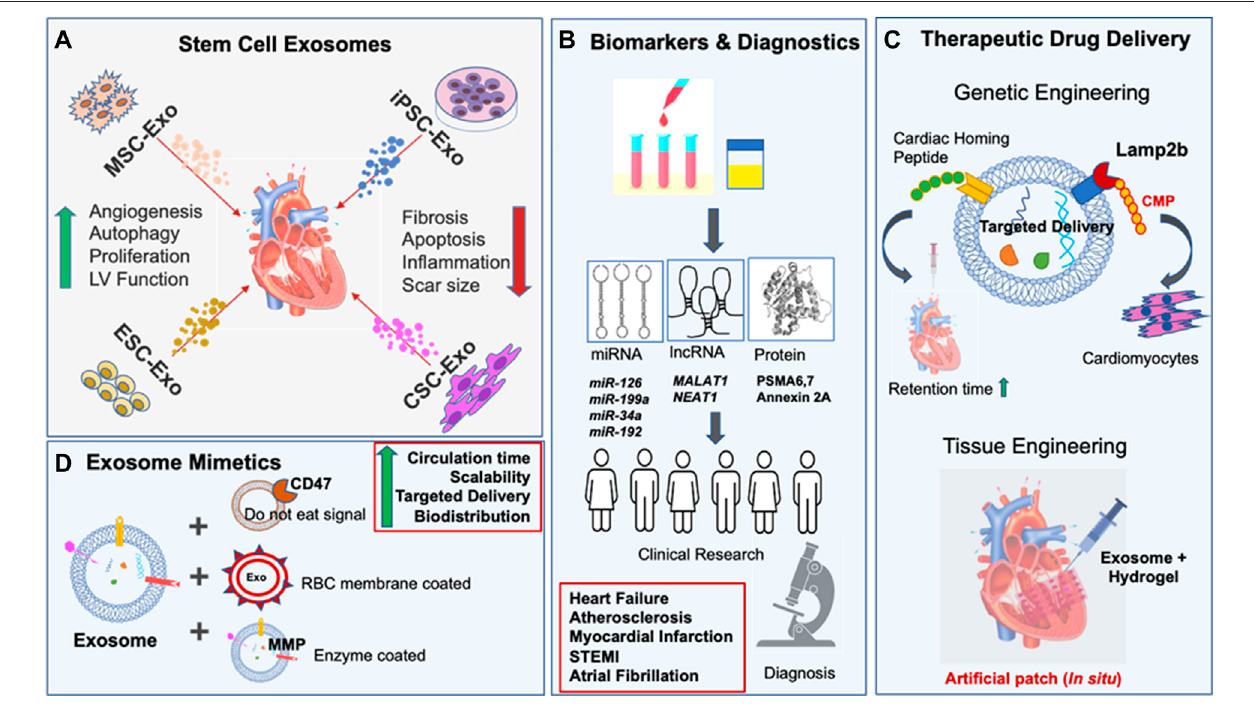
FIGURE 1 | Role of stem cell exosomes in cardiovascular diseases. (A) Top panel indicates various stem cell exosomes involved in cardiac repair. The effective cardioprotectivemechanismsarelisted.Arrowsindicatetheregulationofvariousbiologicalfunctions. (B) Schematicrepresentationofapplications ofstemcellexosome as source of biomarkers for disease diagnosis. (C) Engineering strategies implemented to modulate the exosome properties are shown here. (D) Exosome-mimetics, designed using nanomedicine, enhance the therapeutic potential of natural exosomes.